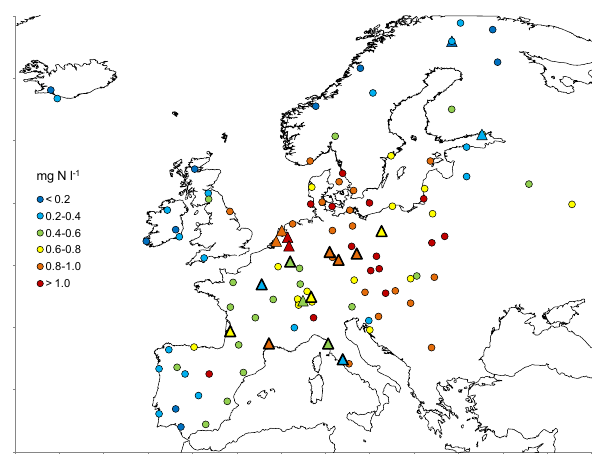
Fig. 1. Annual rainfall-weighted average concentrations (mgNl − 1 ) ) in precipitation across Europe. The of inorganic N (NH + and NO − 4 3 circles show colour-coded concentrations from the EMEP monitor- ing sites for 2009 (http://ebas.nilu.no/), and the triangles show the data from this study for comparison (see Table 1 for details). “Level Updated Figure 1: Cape et al. bg-2012-249 1” sites are shown with bold